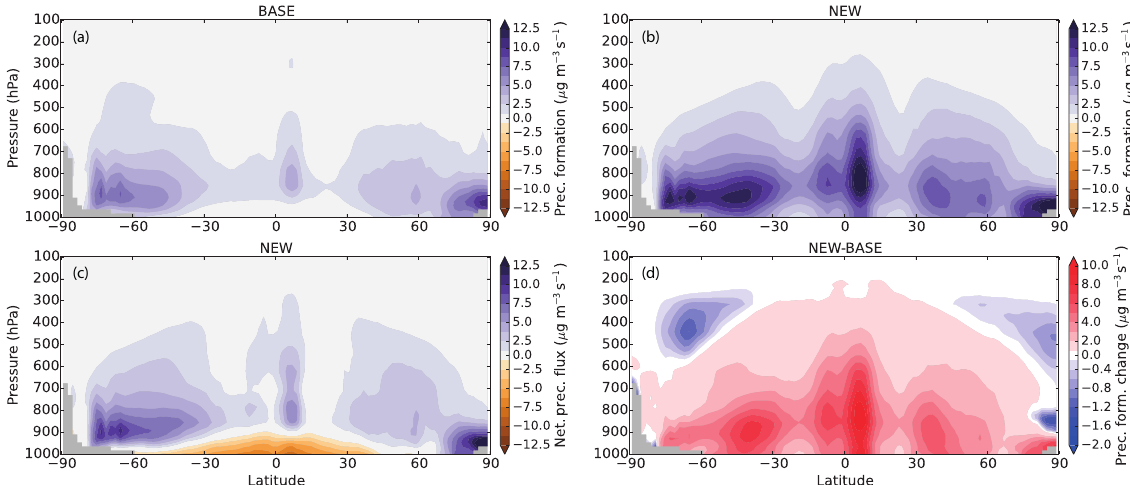
Figure 5. Zonal mean annual mean precipitation formation rate (µgm − 3 s − 1 ) in (a) the BASE simulation and (b) other simulations, and (d) the differences between these. (c) Net precipitation flux (formation − evaporation) in other